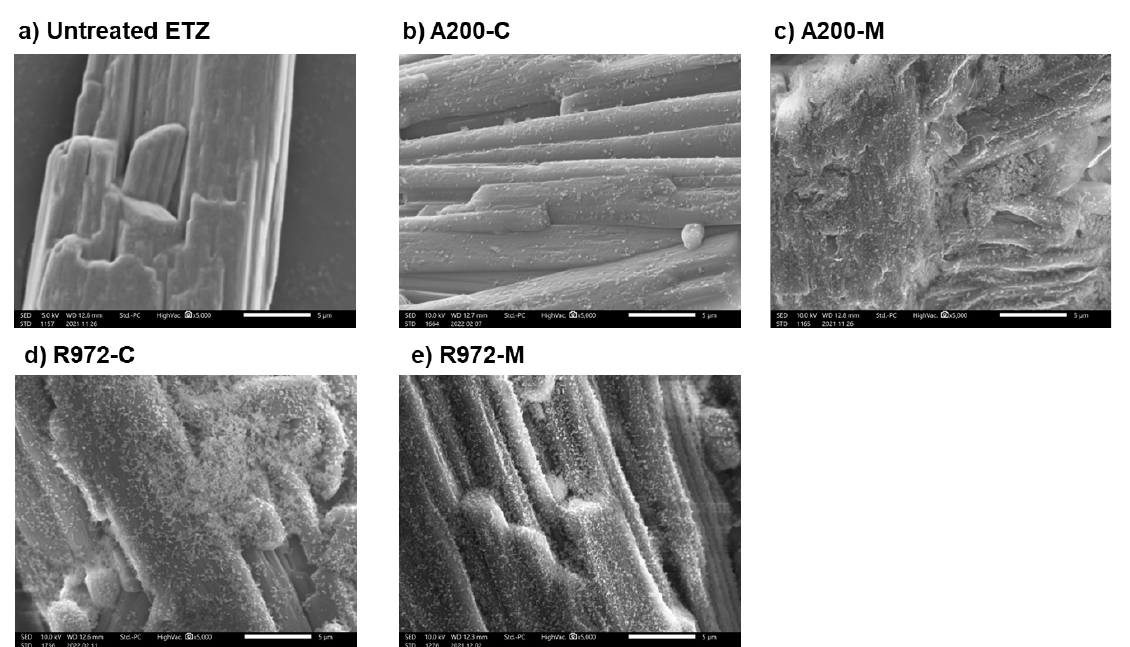
Figure 3. SEM images demonstrating the surface morphologies of ethenzamide (ETZ) particles treated with different types of silica nanoparticles using different dry-coating methods: ( a ) Untreated ETZ without silica nanoparticles; ETZ coated with A200 silica nanoparticles using the ( b ) Comil (A200-C) and ( c ) Mechanomill (A200-M) coating methods; ETZ coated with R972 silica nanoparticles using the ( d ) Comil (R972-C) and ( e ) Mechanomill (R972-M) coating methods.